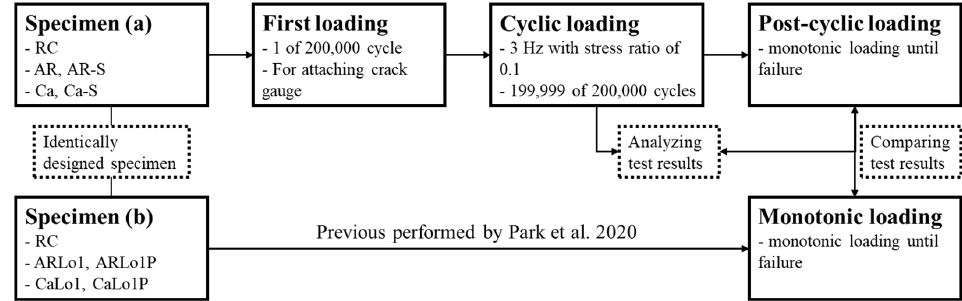
Figure 2. Process of experiment: ( a ) Cyclic loading test in this study; ( b ) Monotonic loading test in previous study [38].